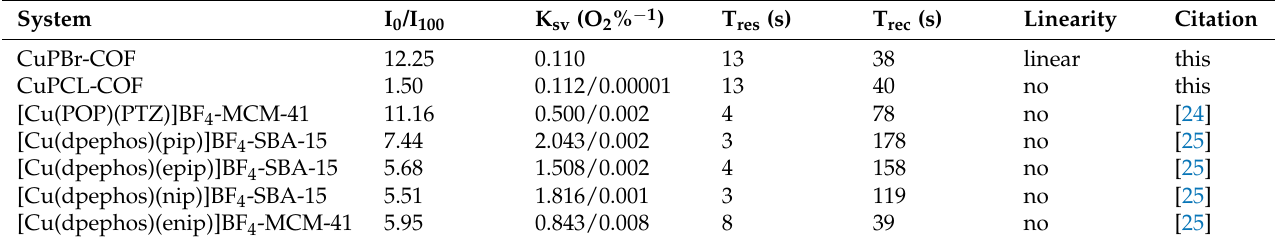
Table 1. Key sensing parameters of CuPX-COF and literatures.